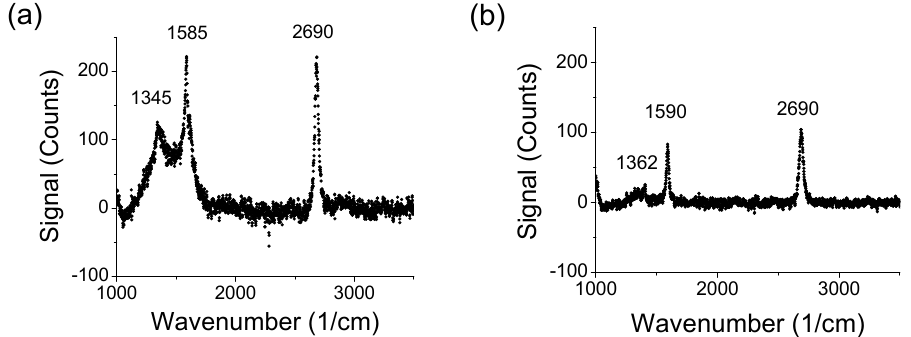
Figure 8. Comparative Raman spectra of bilayer graphene deposited with alumina when transferred onto thermally prepared 50-nm SiO 2 /Si. ( a ) 10-nm alumina on transferred graphene. ( b ) 5-nm alumina on a transferred graphene. Raman data were obtained with a 532 nm laser.